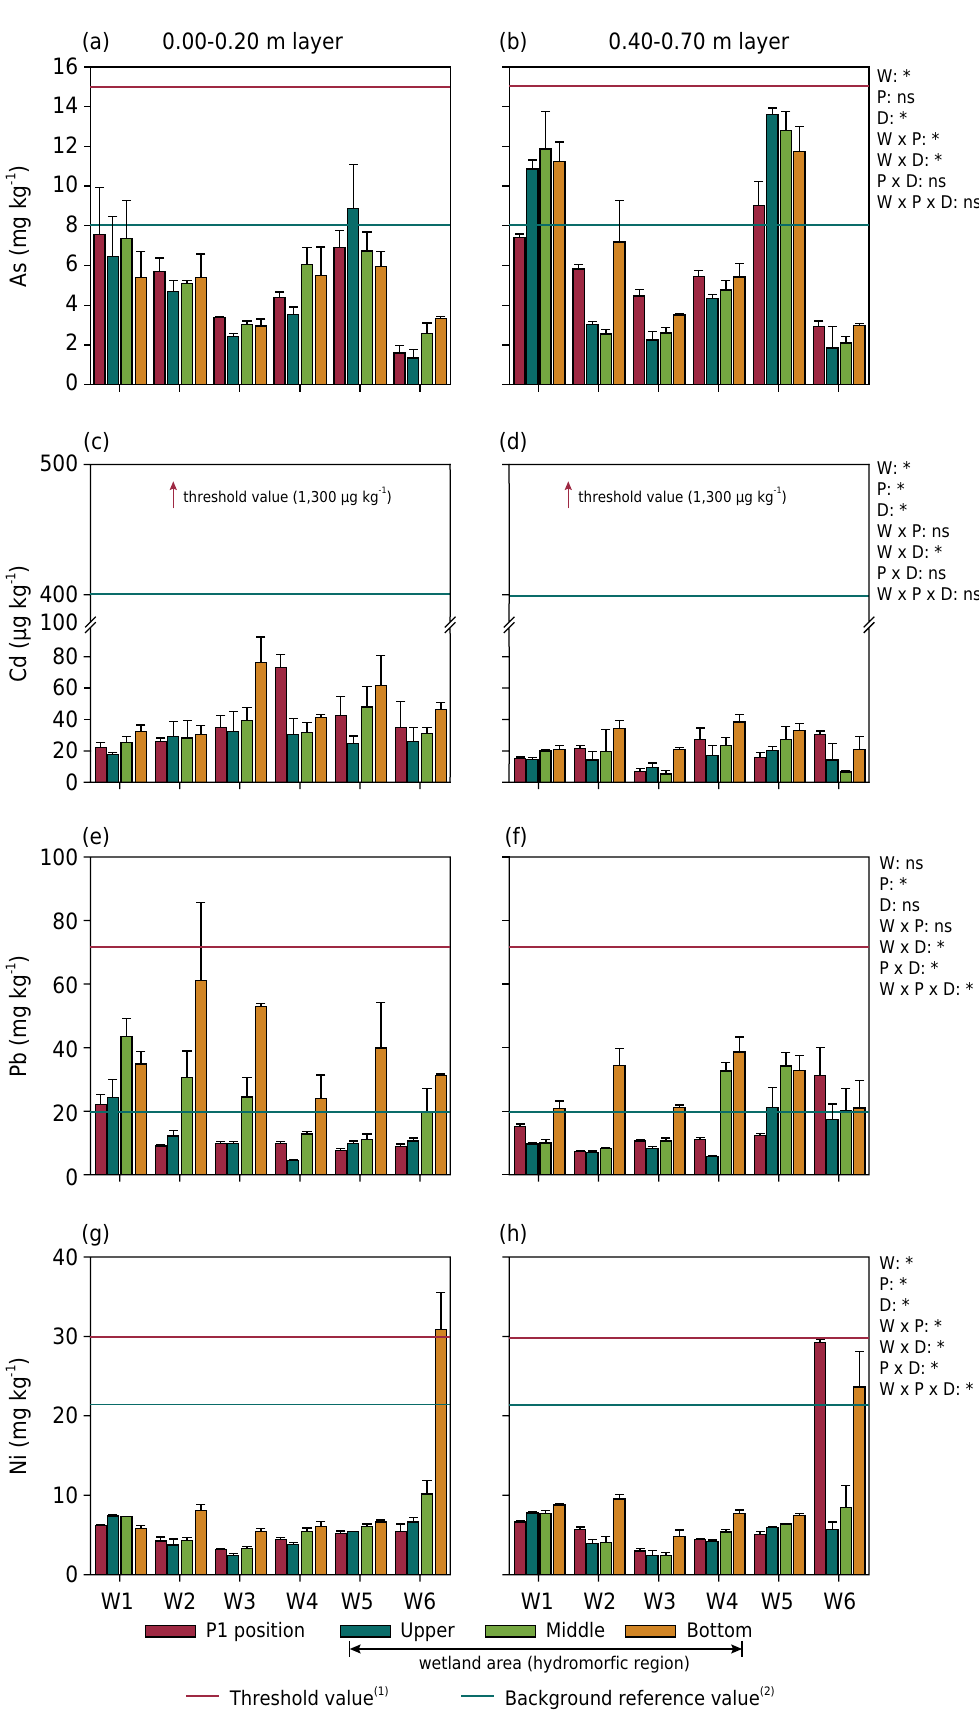
Figure 4. Arsenic, Cd, Pb, and Ni contents in wetland soils of Brazilian Cerrado, Triângulo Mineiro region, Brazil. Error bars indicate the standard error (n = 3). (1) and (2) : threshold and background (or quality reference) values established by Brazilian guidelines, Minas Gerais State, Brazil (Copam Normative Deliberation